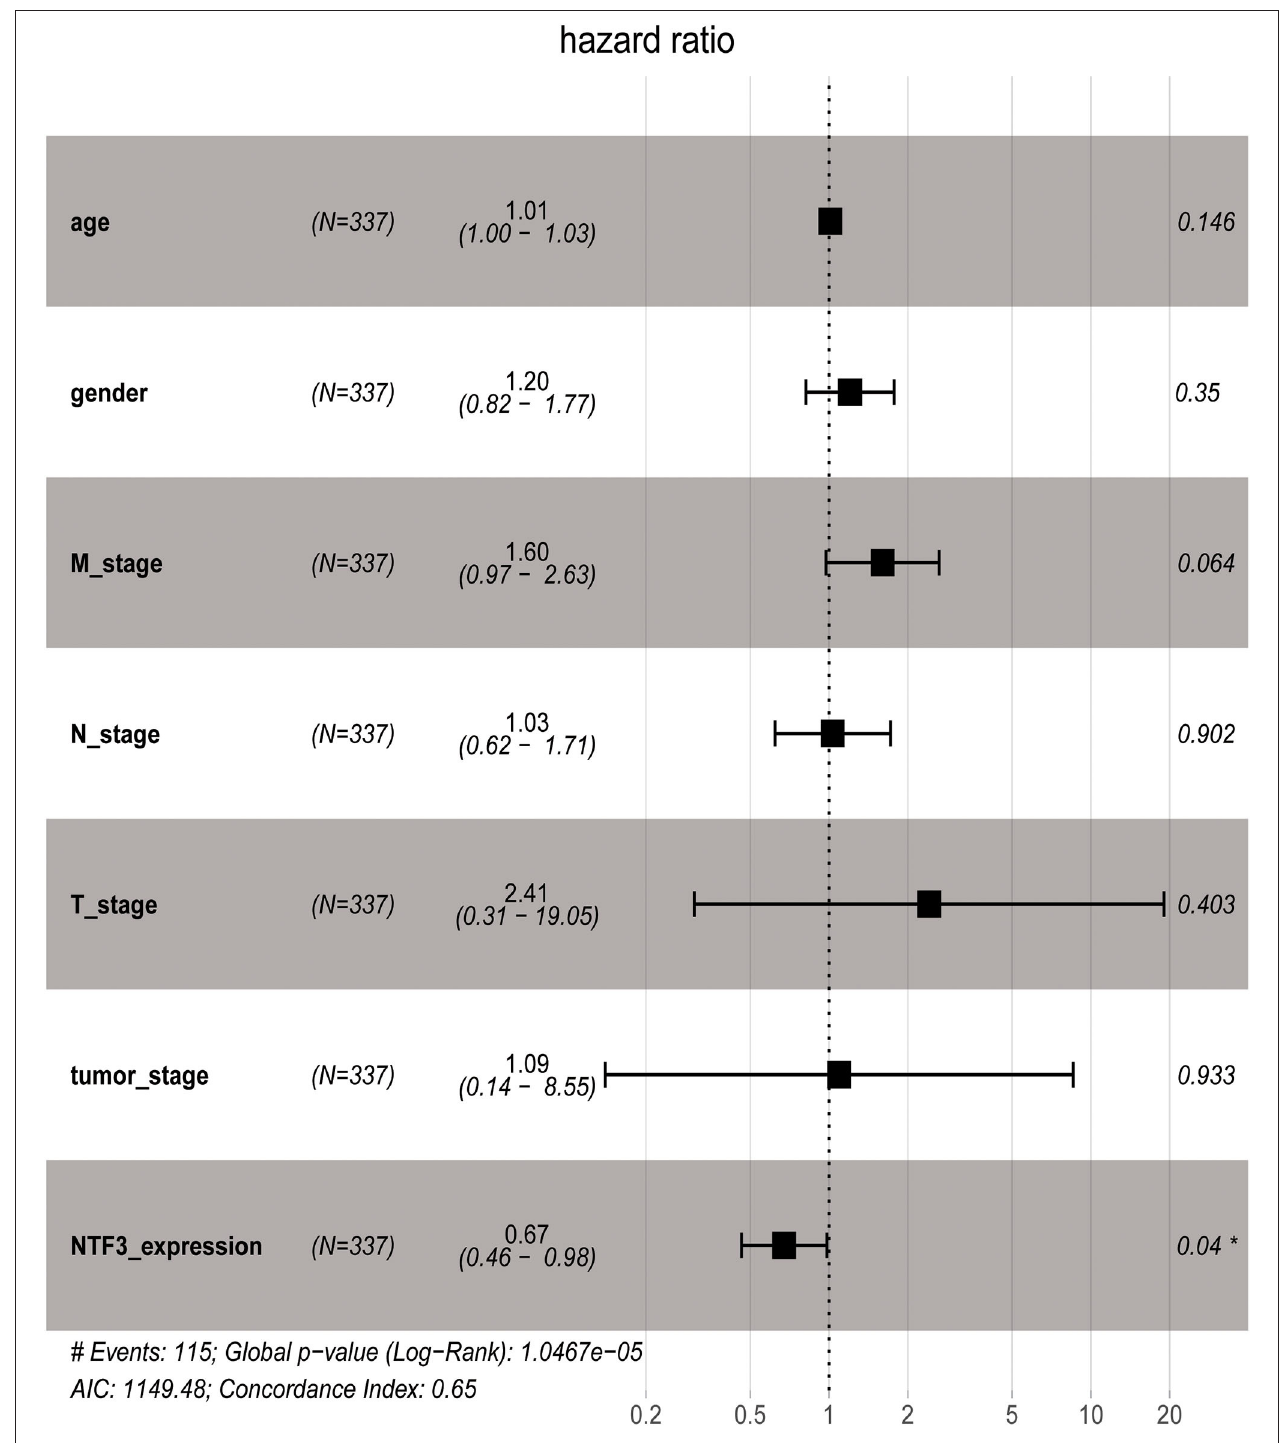
FIGURE 5 | Multivariate Cox analysis of NTF3 expression and some clinical pathological factors.